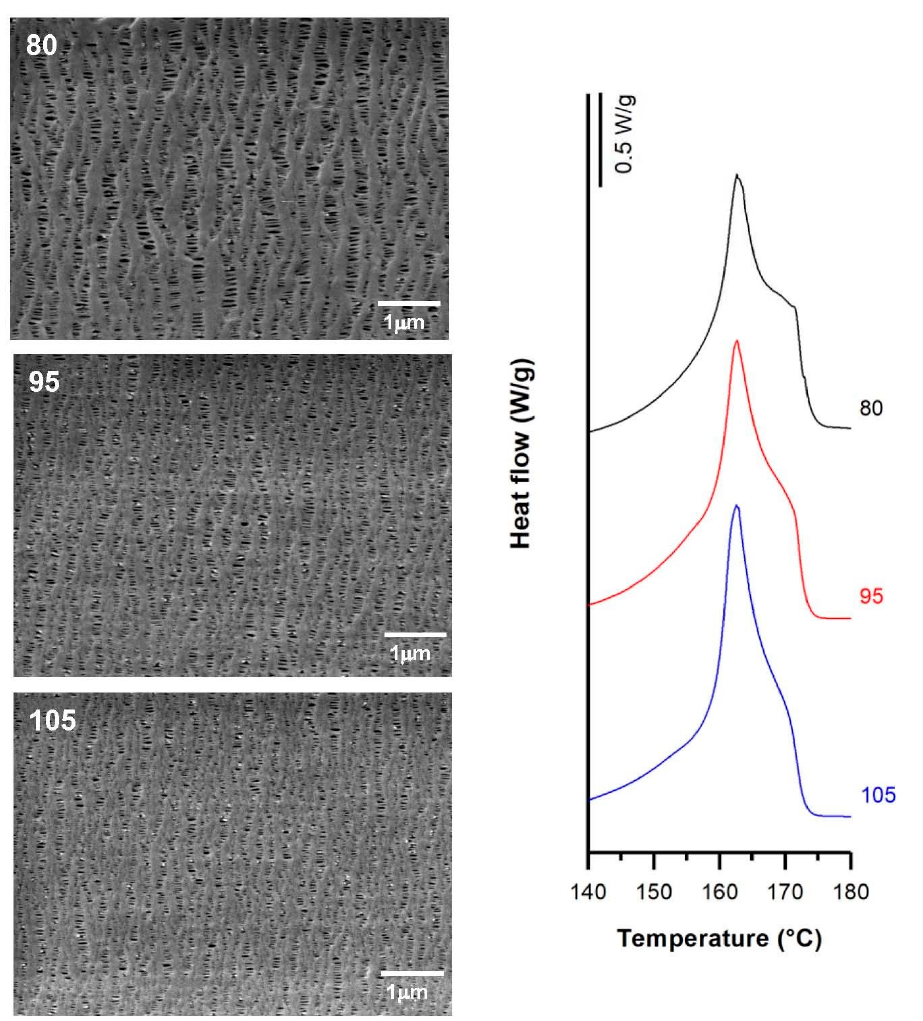
6 Figure 6. SEM micrographs and Differential Scanning Calorimetry (DSC) thermograms of H1-2BR, differing in their draw ratio. Processing conditions: Gap die, 1.9 mm; cold stage 0.3 mm/min, 20%; hot stage, 0.3 mm/min,